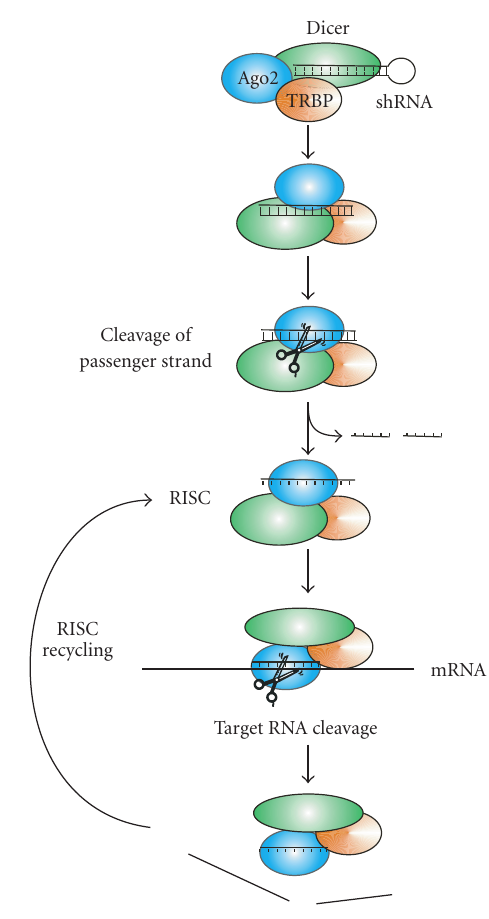
Figure 2: Model for assembly and function of RISC according to [31] under consideration of [32,